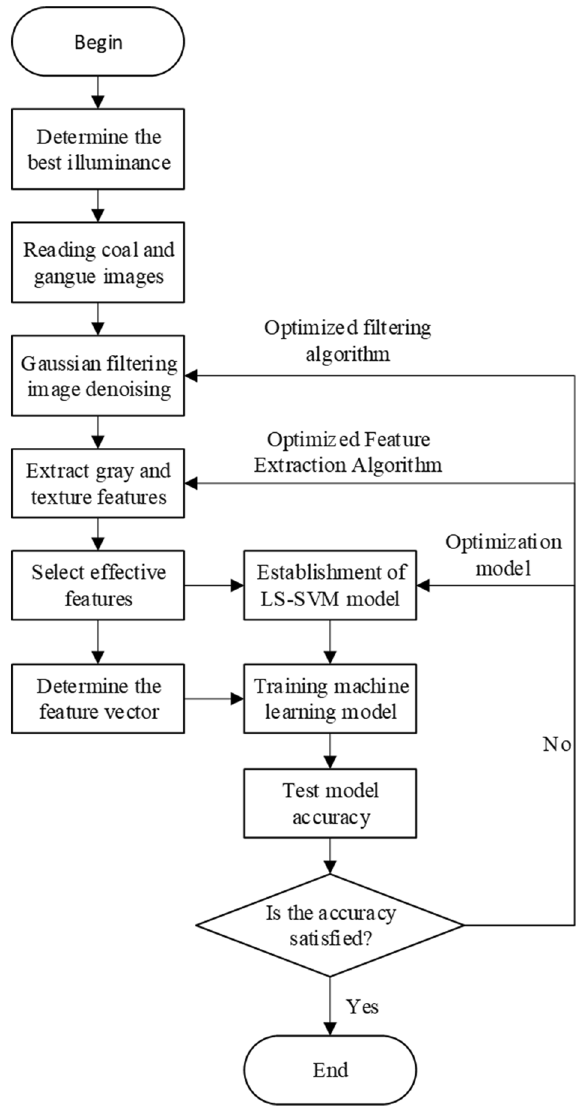
Figure 15. Flow chart of coal gangue identification